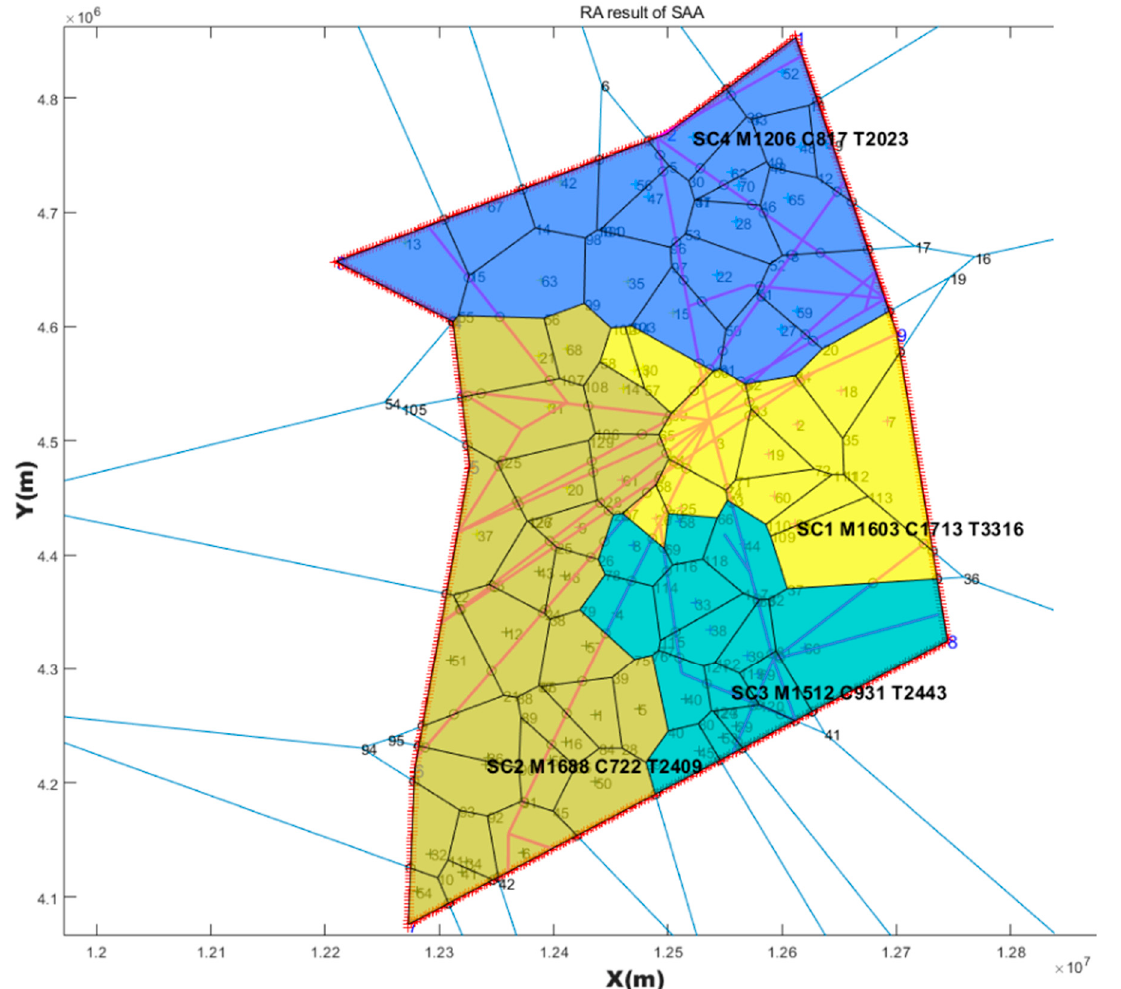
Figure 14. Reconfiguration results based on random seeds with SAA .